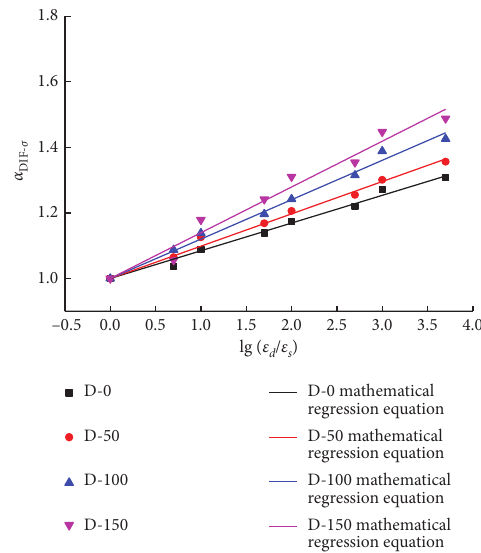
Figure 8: The effect of strain rate on the dynamic increase